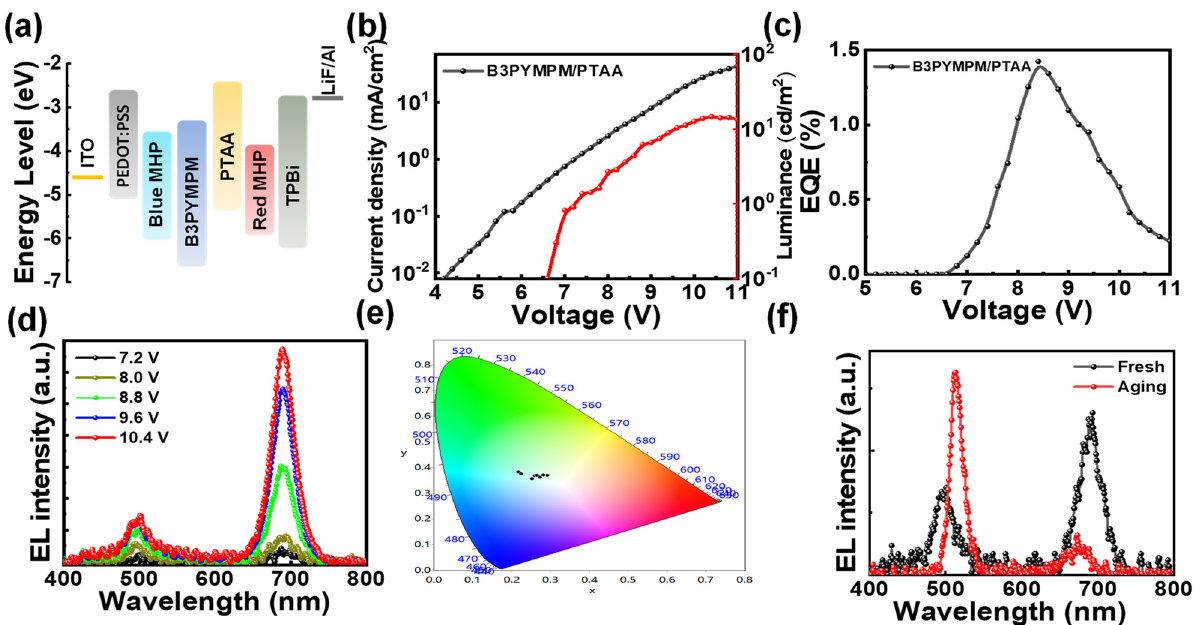
Figure 3. ( a ) Energy level diagram of tandem PeLEDs. ( b ) Current density and luminance versus voltage plots of tandem PeLEDs. ( c ) EQE versus voltage plots of tandem PeLEDs. ( d ) EL spectra of tandem PeLEDs at different biases. ( e ) CIE coordinates. Each black dot corresponds to the spectra in Figure d. ( f ) The EL spectra of a fresh and an aging device.